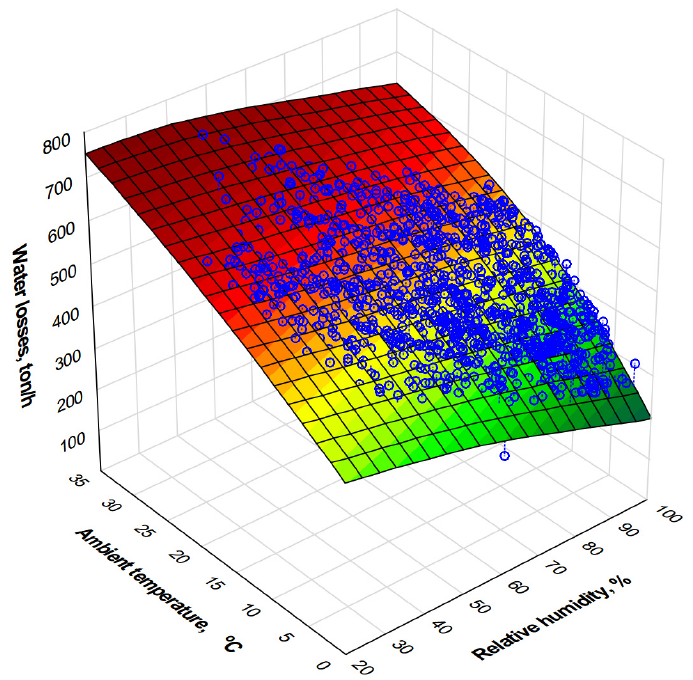
Figure 4. Dependence of water losses due to evaporation on the function of ambient temperature, relative humidity ( B = 400 ± 10 MW).